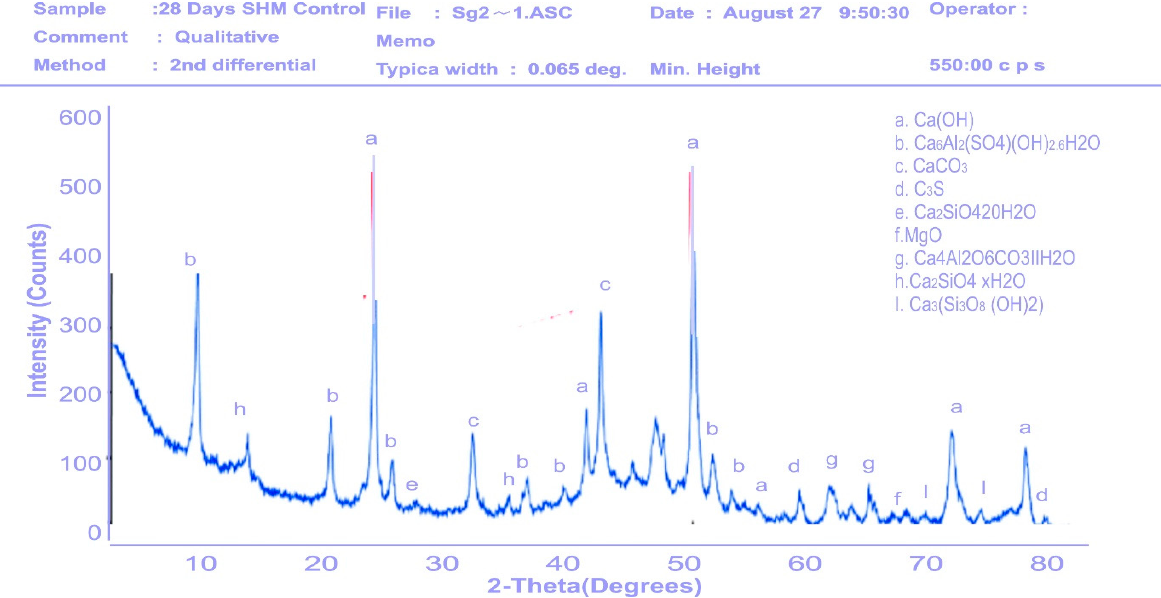
Figure 12. XRD pattern of the SPM-30 sample at 7 days.